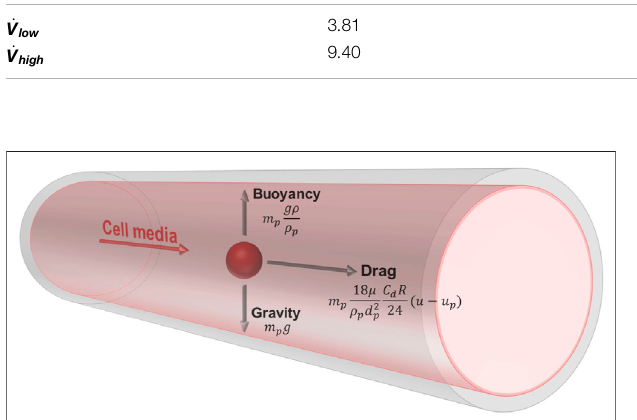
TABLE 1 | Cell seeding boundary conditions and values. Flow rate is speci fi ed at the inlet artery, and pressures are speci fi ed at the outlet vein. Case